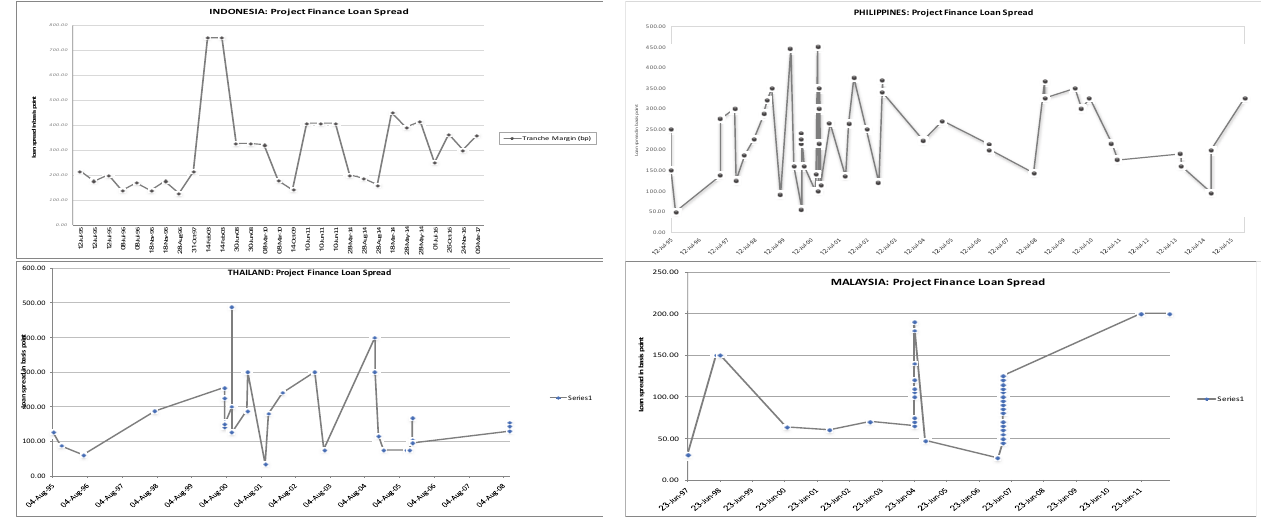
Fig. 1. Project finance loan spread over LIBOR in the ASEAN four countries for selected project